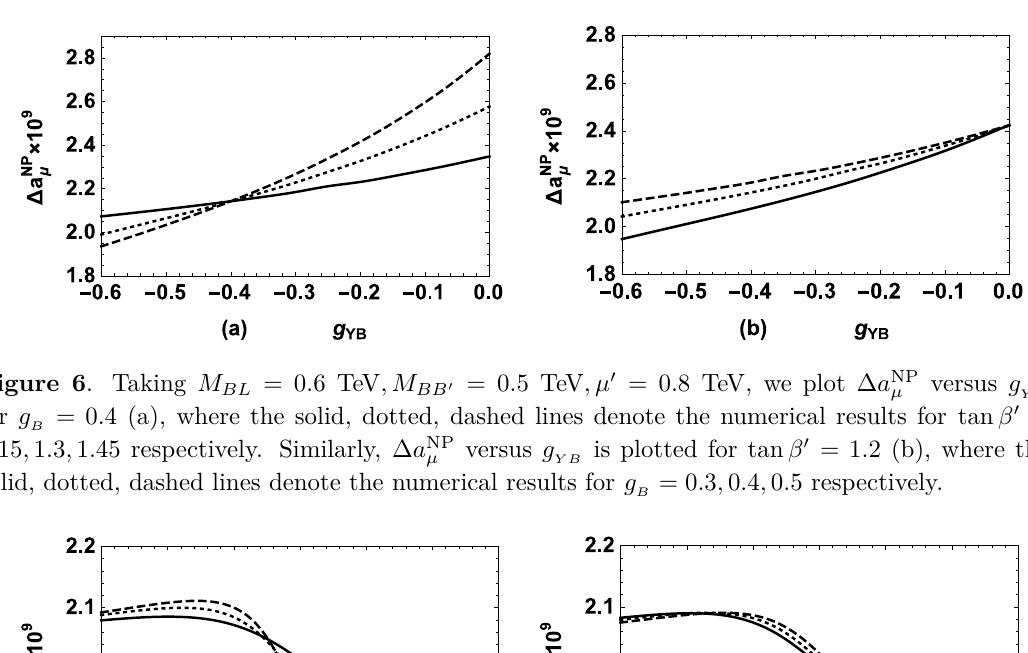
Figure 7 . Taking g = − 0 . 4 , g = 0 . 2 , tan β 0 = 1 . 2 , we plot ∆ a NP versus M BB 0 for µ YB B M BL = 0 . 5 TeV (a), where the solid, dotted, dashed lines denote the numerical results for µ 0 = 0 . 5 , 1 . 5 , 2 . 5 TeV respectively. Similarly, ∆ a NP versus M BB 0 for µ 0 = 0 . 8 TeV (b) is plot- µ ted, where the solid, dotted, dashed lines denote the numerical results for M BL = 0 . 5 , 1 . 5 , 2 . 5 TeV